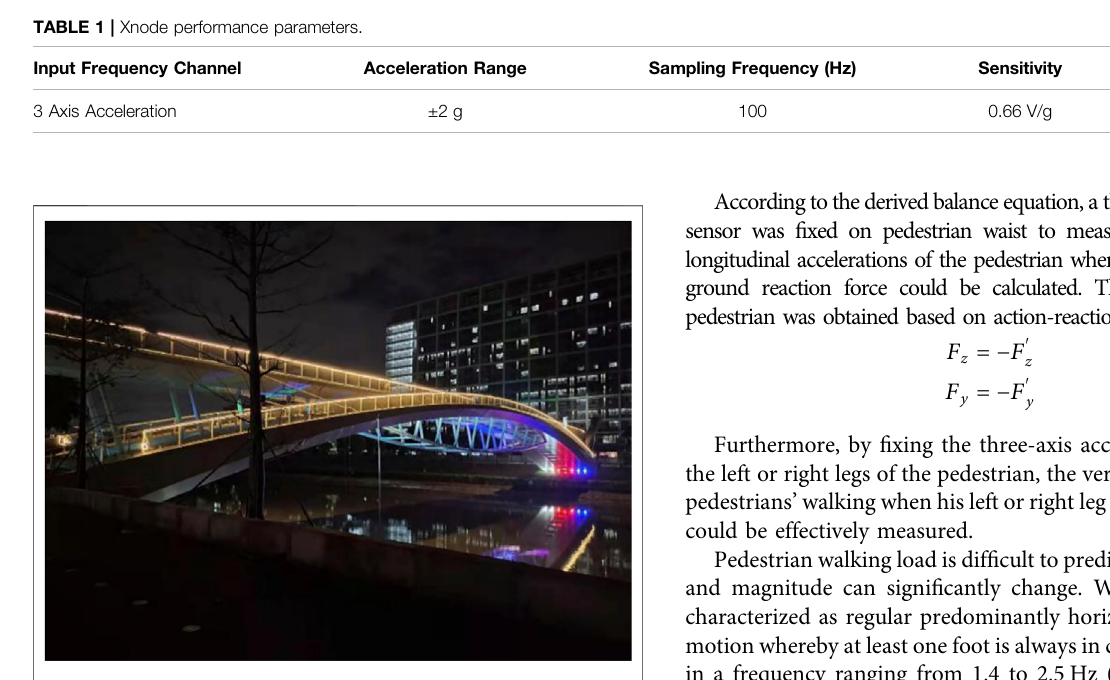
FIGURE 5 | Yanluo